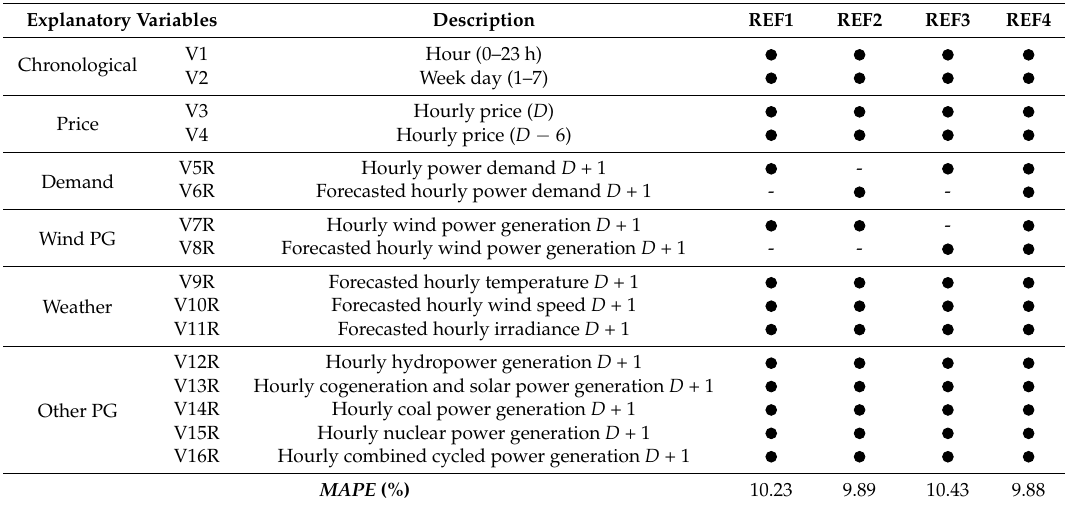
Table 4. RMPE models and their mean absolute percentage errors ( MAPEs